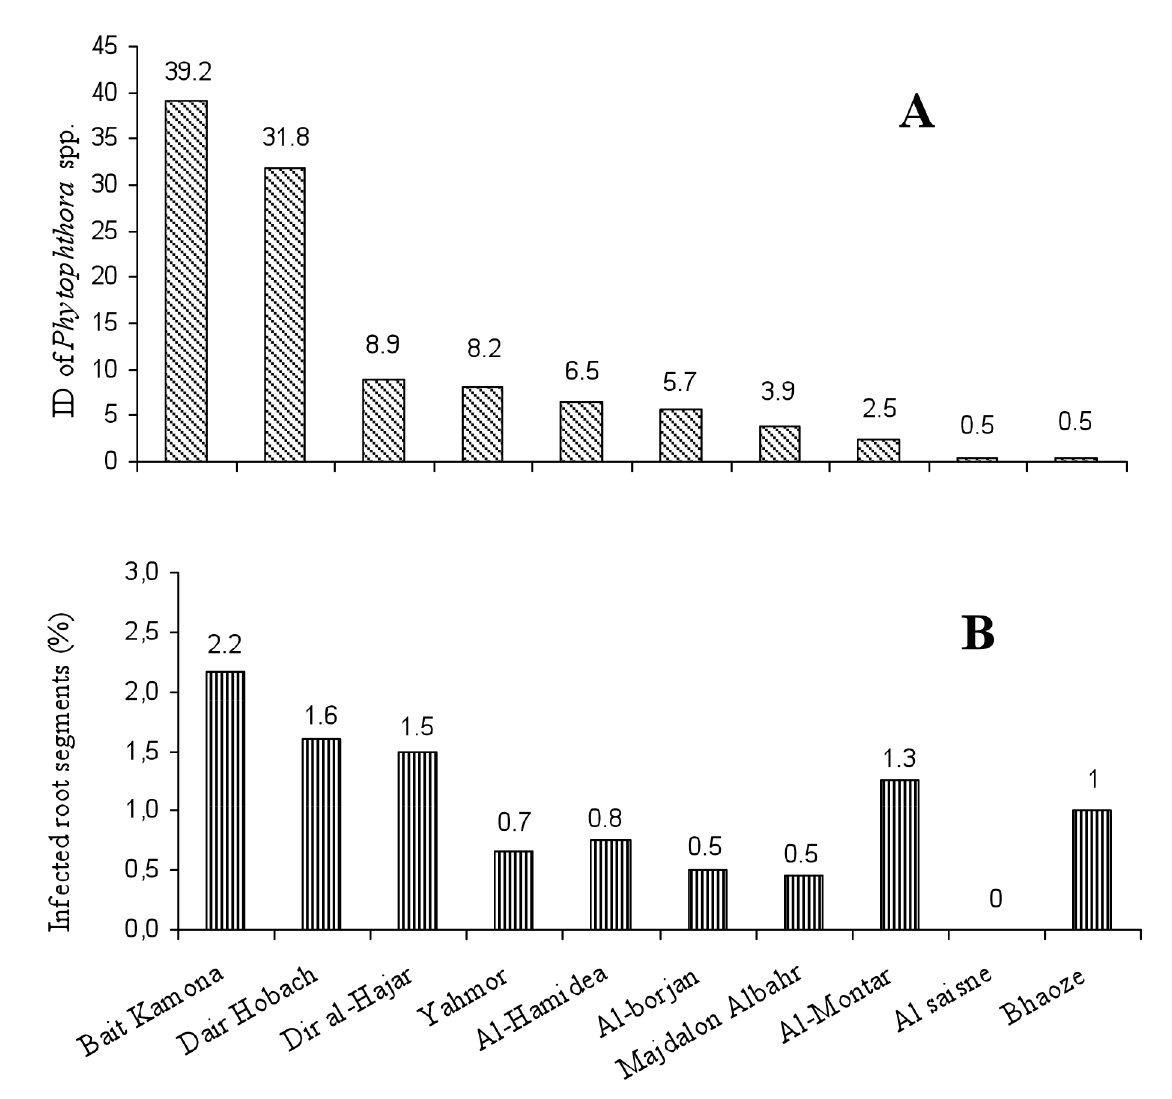
Figure 2. Inoculum density (ID) of Phytophthora spp. (propagules gram -1 of dry soil) (A), and percentage of infected roots (B) in monitored locations in Tartus